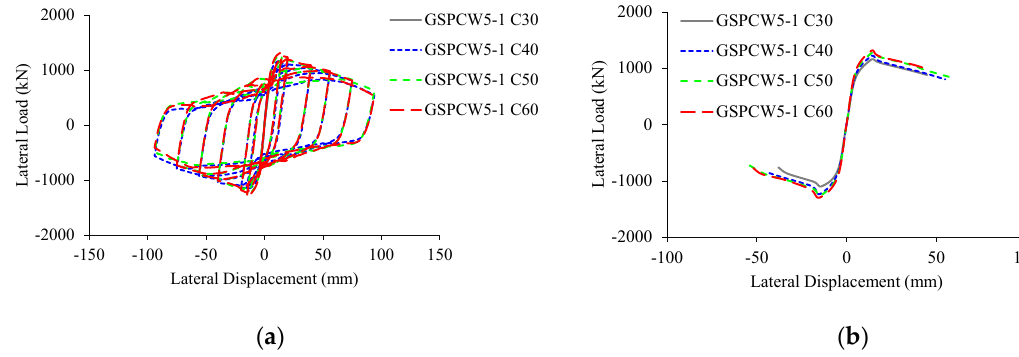
Figure 11. Influence of concrete compressive strength: ( a ) load–displacement hysteresis curves, and ( b ) skeleton curves.